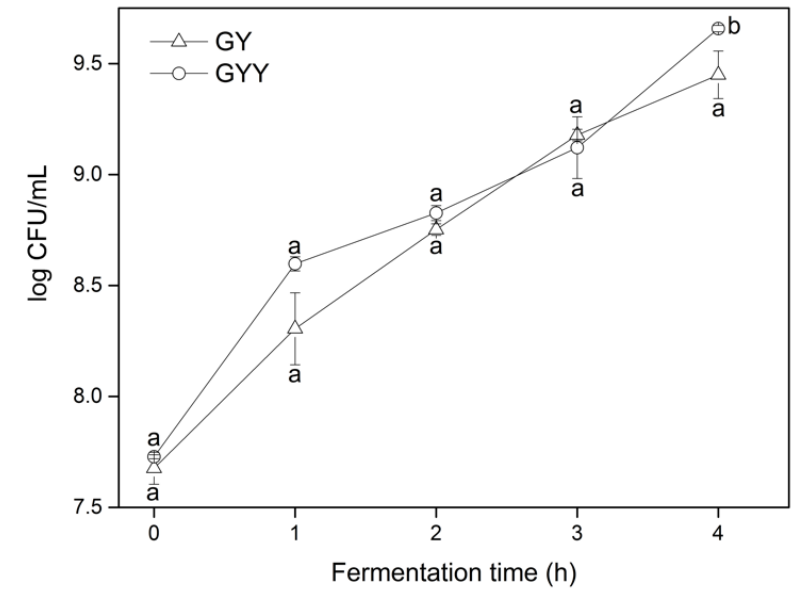
Figure 1. Population of total lactic acid bacteria (LAB) in goat yogurt (GY) and goat milk co-fermented with yeast and lactic acid bacteria (GYY) during fermentation.